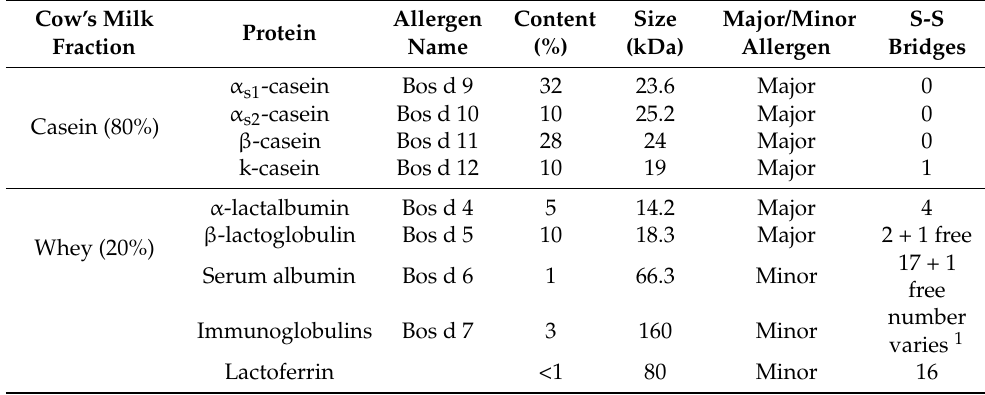
Table 1. Cow’s milk allergens and their characteristics. Table modified from [53]. Allergen Cow’s Milk Protein Fraction